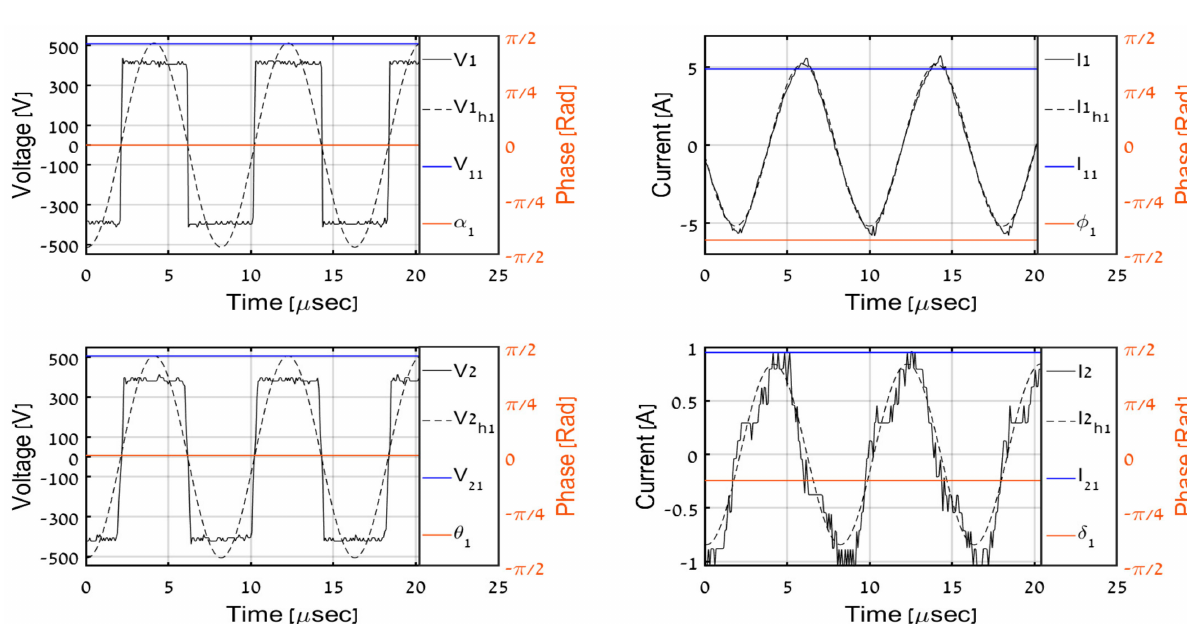
Figure 15. Experimental results, P O = 600 W.